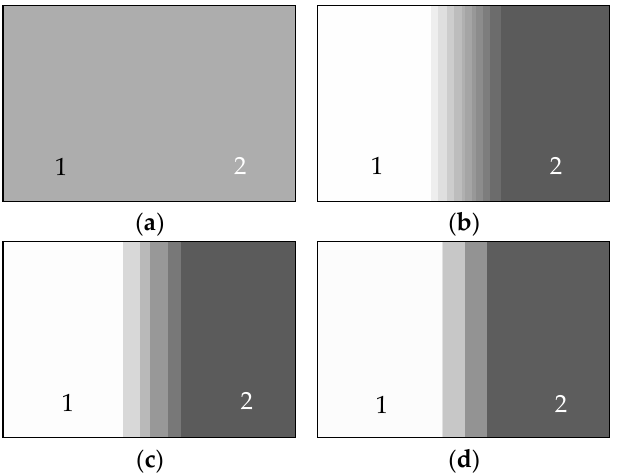
Figure 4. Mean shift segmentation results of Figure 3b using ( a ) the row-column strategy with range bandwidth h = 15 and 30 (same result); and, ( b )–( d ) the pre-sorting strategy with range bandwidth h = 30, 60, and 90, respectively.